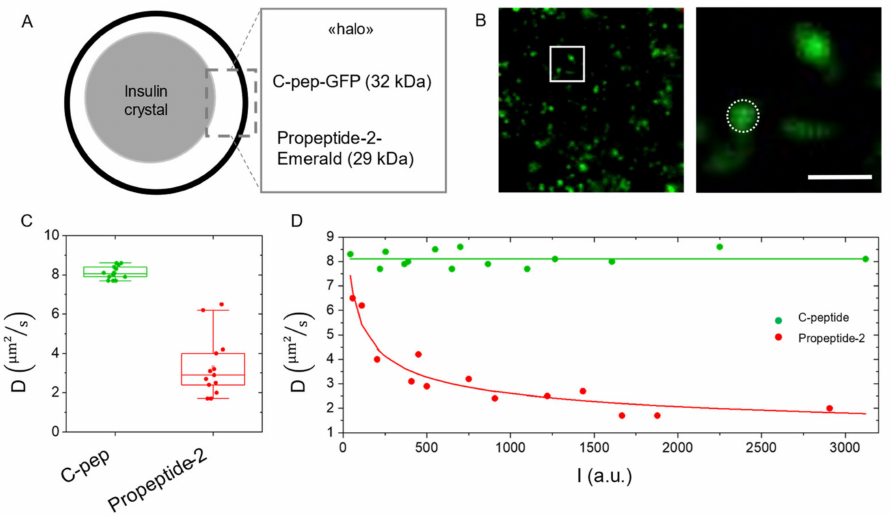
Figure 4. Time-tunable RICS application to the measurement of molecular aggregation within ISGs. ( A ) Schematic representation of an ISG, showing the typical structure with an internal core of crystallized insulin and a luminal “halo” surrounding the crystal ( B ) Confocal image of an insulinoma 1E cell labeled with proinsulin-GFP (left) and magnification of the white square in, i.e., the region used for the time-tunable RICS experiment (right, scale bar: 2 µ m). ( C ) Plot of the diffusion coefficients of C-pep-GFP and propeptide2-Emerald (Mean ± SD) measured in INS-1E at 2 µ s/pixel. ( D ) Here the measured diffusivity values are plotted against the mean fluorescence recorded in the subcellular structures captured by imaging. Propeptide-2-Emerald data fitting (reported in Figure 4) had been performed using Python, specifically the scipy.optimize.curve_fit () function which implements the Levenberg–Marquardt algorithm for nonlinear least squares fitting. The fitting equation has been chosen by taking into account the proportionality between diffusion coefficient ( D ) and molecular weight (MW) (Equations (2) and (3) in Section